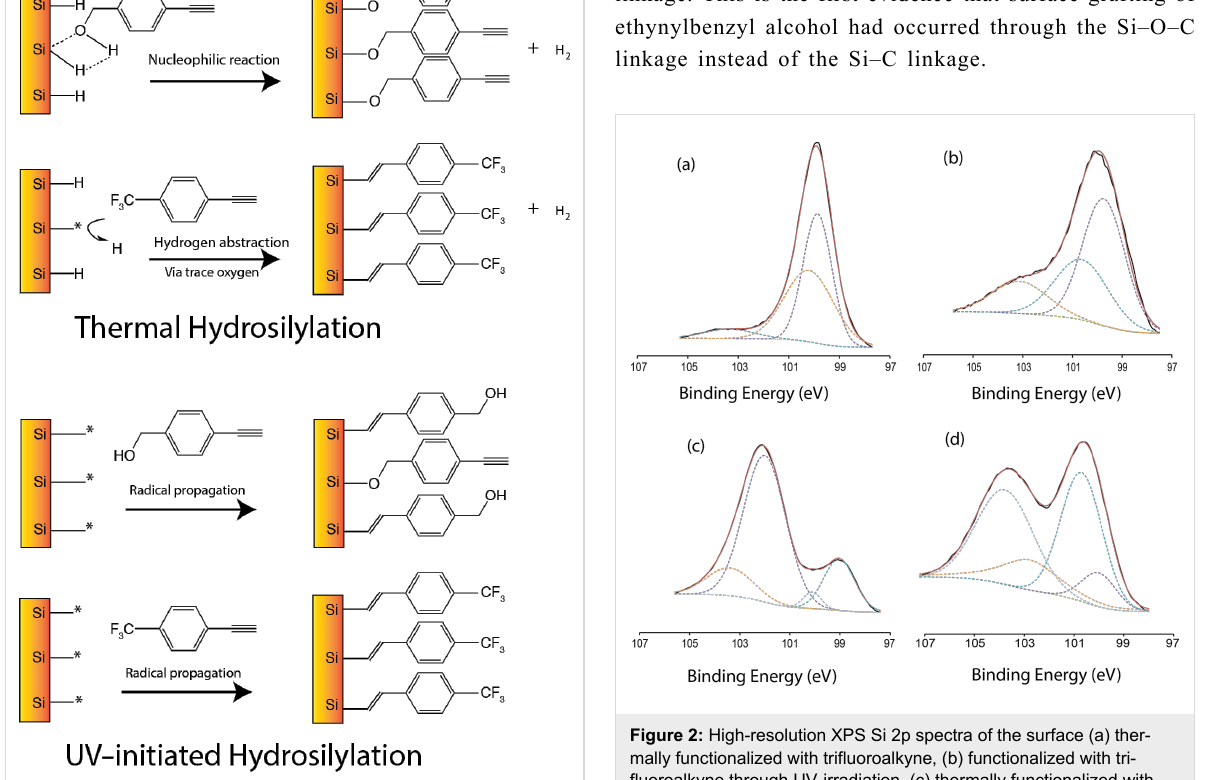
High-resolution XPS analyses were performed on thermally grafted as well as UV-irradiated surfaces well for both trifluoro- alkyne and ethynylbenzyl alcohol (Figure 2). The Si 2p spectra for thermally treated trifluoroalkyne and ethynylbenzyl alcohol